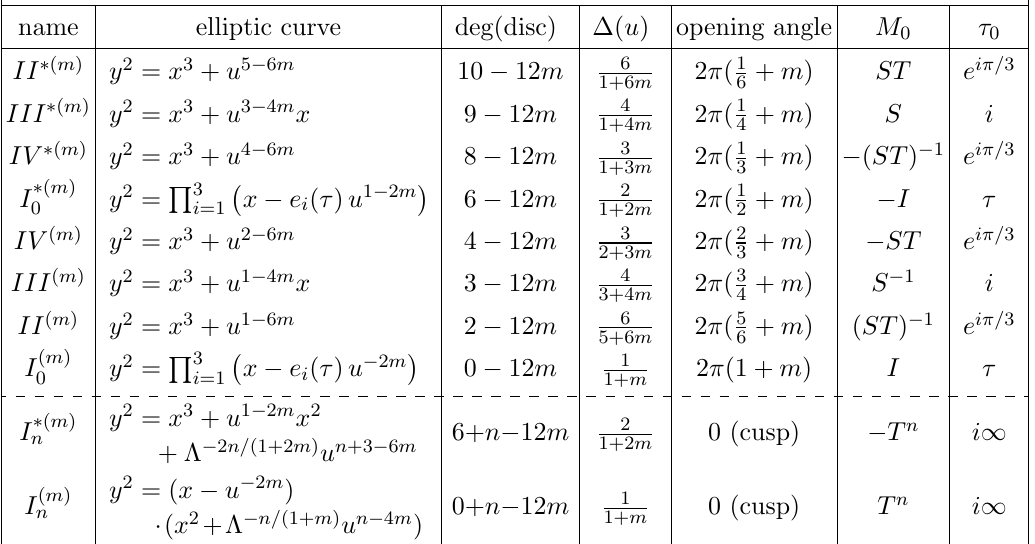
Table 2 . Weierstrass forms of rank 1 special K(cid:127)ahler singularities with (cid:10) = du ^ dx=y , i.e., in regular gauge. m (cid:21) 0 and n > 0 are integers. The third column gives the order of the zero or pole of the discriminant of the curve at u = 0. The last four columns are as in table 1. The I (cid:3) ( m ) n and I ( m ) n singularities have a parameter (cid:3) of mass dimension 1, so are not scale invariant. Their elliptic curves have, in addition to the singularity at u = 0, further singularities at u (cid:24) (cid:3) (cid:1)( u ) which are not pertinent: the curves are only meant to capture the scaling behavior for j u j (cid:28) j (cid:3) j (cid:1)( u ) .